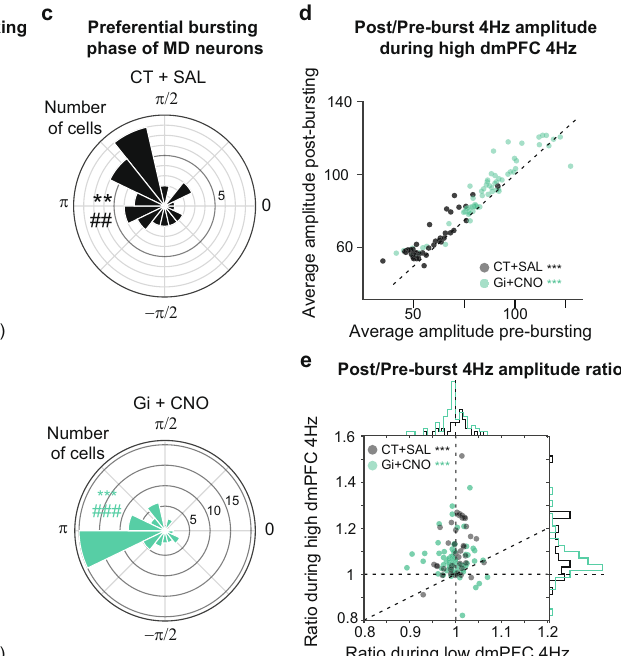
ofdmPFC4Hzoscillationsduringthe500msfollowingMDburstingisincreased compared to the 500ms preceding the burst during high dmPFC 4Hz episodes. e The ratios of the average 4Hz amplitude during the 500ms after and before MD bursting are higher during episodes of high dmPFC 4Hz compared to epi- sodes of low dmPFC 4Hz, vertical and horizontal dotted lines are centered on 1, the diagonal dotted line corresponds to equal ratios in both conditions. Dis- tributions of ratios in both conditions are displayed in the marginal histograms. Wilcoxon test, *** p <0.001. (CT+SAL=39 neurons recorded from 4 mice, Gi+ CNO=67 neurons recorded from 5 mice). Data available at doi:10.5061/ dryad.9kd51c5ng. All tests are two-sided. Detailed statistical results are available in the Supplementary Tables referenced by panel